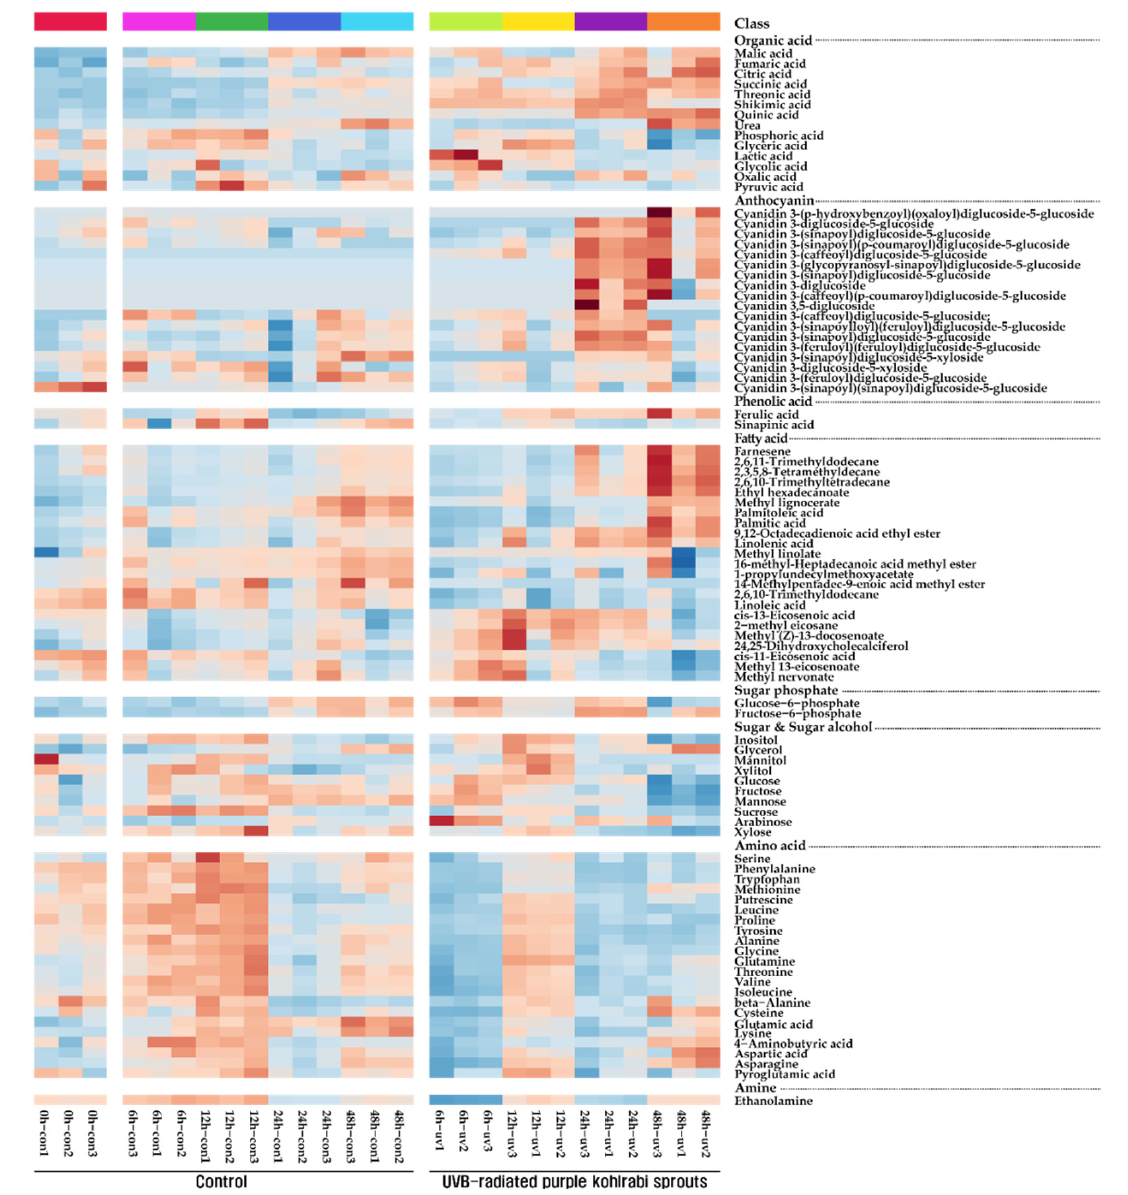
Figure 1. Heatmap representing changes in metabolite composition of purple kohlrabi sprouts in response to UVB irradiation. The colors indicate the relative content of each metabolite identified in control, purple kohlrabi sprouts grown without UVB treatment for 0 h, 6 h, 12 h, 24 h, and 48 h, and test, purple kohlrabi sprouts irradiated with UVB radiation for 6 h, 12 h, 24 h, and 48 h.